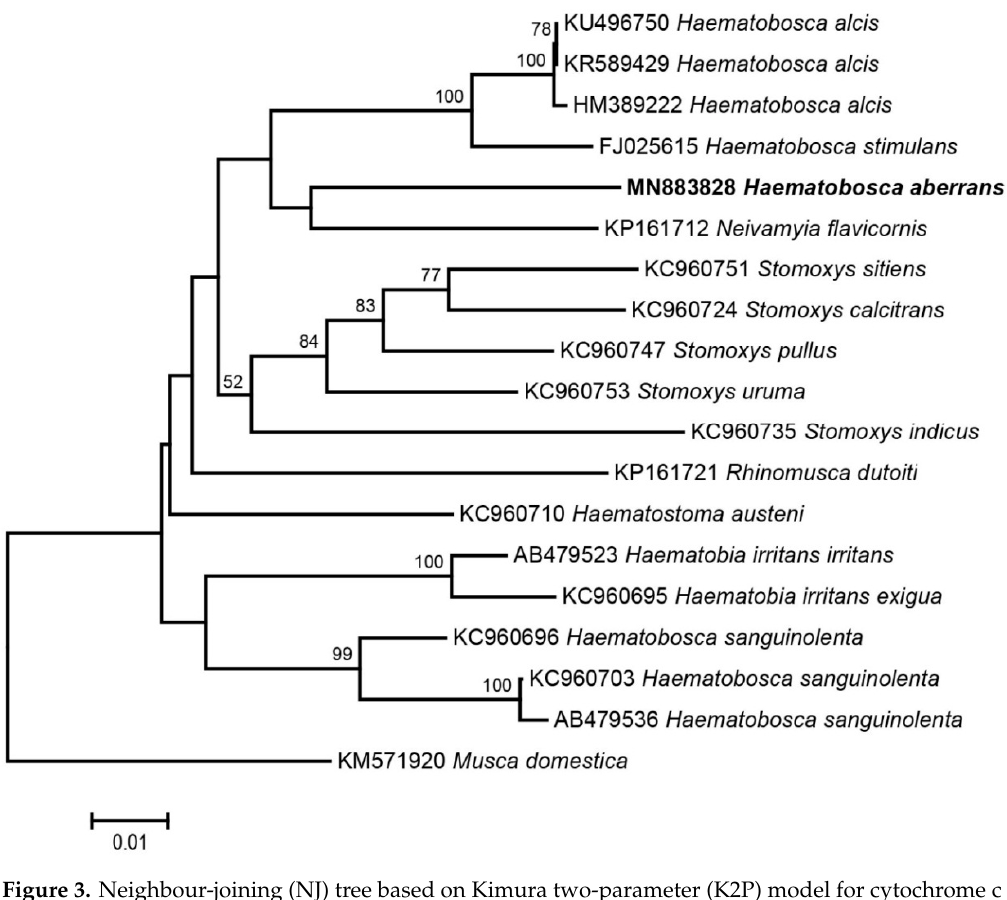
Figure 3. Neighbour-joining (NJ) tree based on Kimura two-parameter (K2P) model for cytochrome c oxidase I (COI) sequence of Haematobosca aberrans Pont, Duvallet & Changbunjong, 2020 collected from northern Thailand and sequences obtained from GenBank. Only bootstrap values ≥ 50% are shown. The scale bar represents 0.01% divergence.